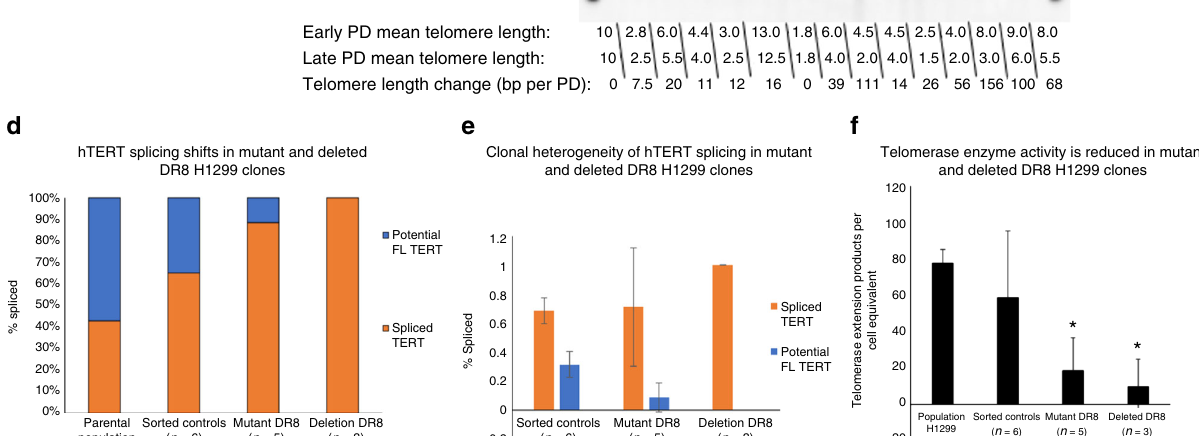
Fig. 5 Deletion of DR8 or mutation of NOVA1 -binding sites in TERT shortens telomeres. a Schematic of CRISPR/Cas9 strategy to delete DR8 in TERT intron 8. b Schematic of CRISPR/Cas9 strategy to mutate NOVA1 -binding sites in TERT DR8. c Terminal restriction fragment length (TRF-Southern blot) analysis of parental, sorted controls, DR8 NOVA1 ’ 7×YAAY ’ mutants, and DR8-deleted H1299 clones. *DR8 mutant 3 and *DR8 deletion 1 stopped growing at population doubling 57 and 85, respectively. d hTERT splicing isoform proportion analysis of parental, averaged sorted controls ( n = 6), averaged DR8 mutants ( n = 5), and averaged DR8 mutants ( n = 3). e hTERT splicing isoform proportion analysis of averaged sorted controls ( n = 6), averaged DR8 mutants ( n = 5), and averaged DR8 mutants ( n = 3). This plot shows the clonal heterogeneity of hTERT splicing in the clones used in this experiment. Standard deviation of the group means displays the variation in the response to mutation or deletion of direct repeat 8 (DR8) in hTERT . Only sorted controls and clones are shown as variation in the parental line is shown elsewhere. f Telomerase activity of parental, averaged controls ( n = 6), averaged DR8 mutants ( n = 5), and averaged DR8 deletion clones ( n = 3). Data are expressed as means and standard deviation where applicable. * p <0.05. Supplementary data associated with this fi gure can be found